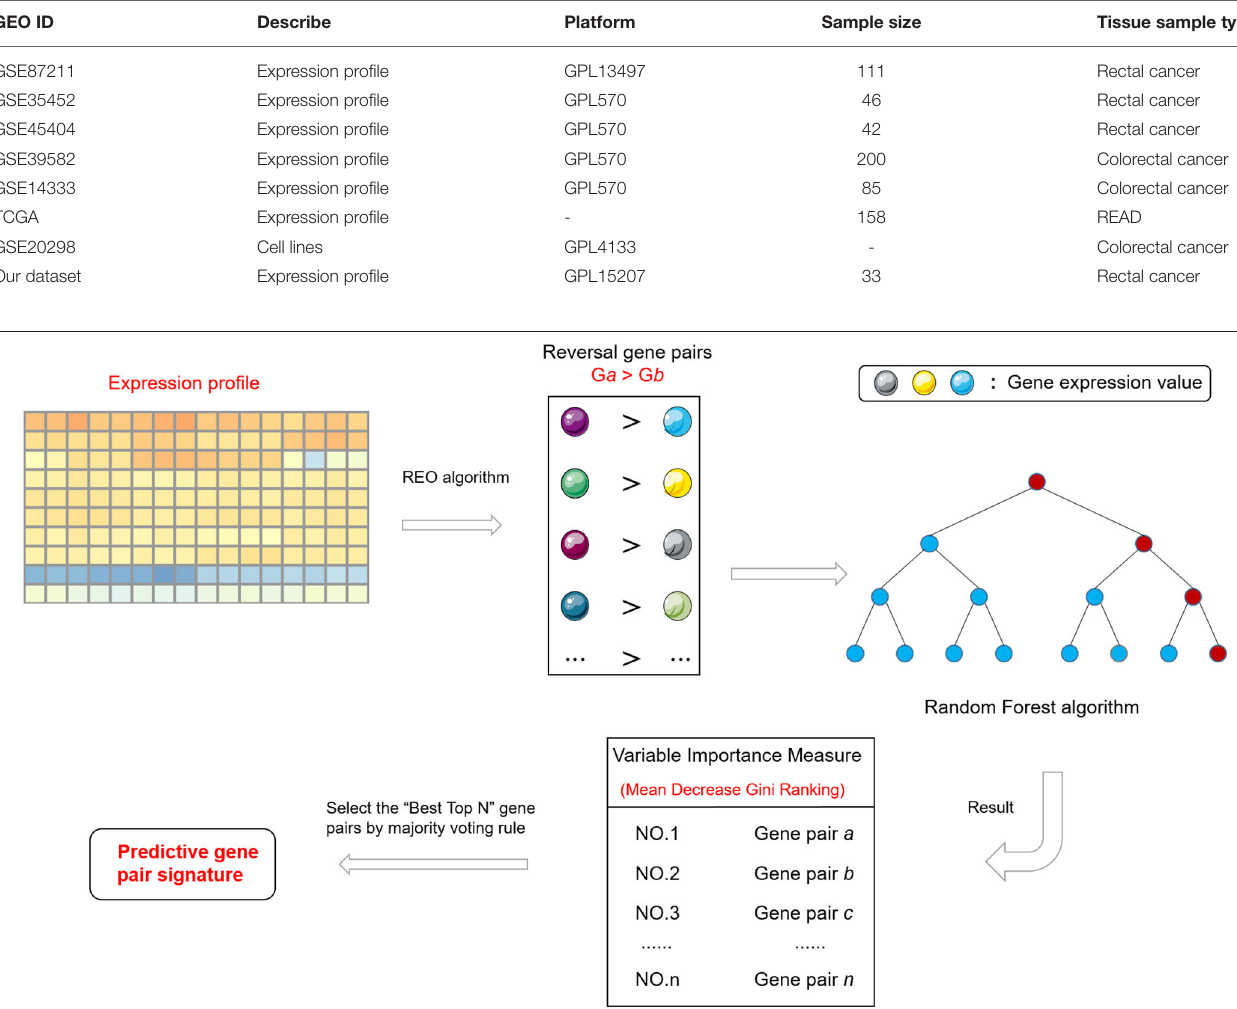
TABLE 1 | Datasets analyzed in this study.